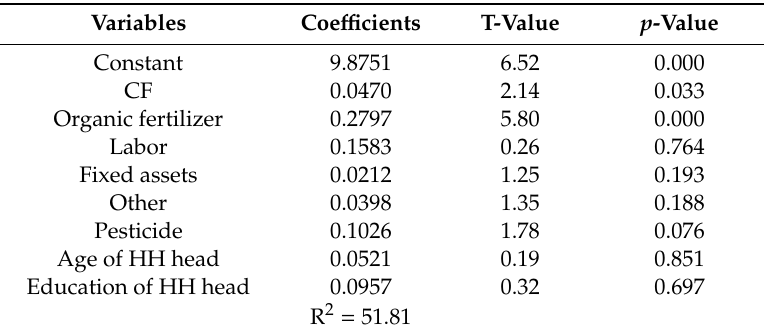
Table 6. Results of the loss control production